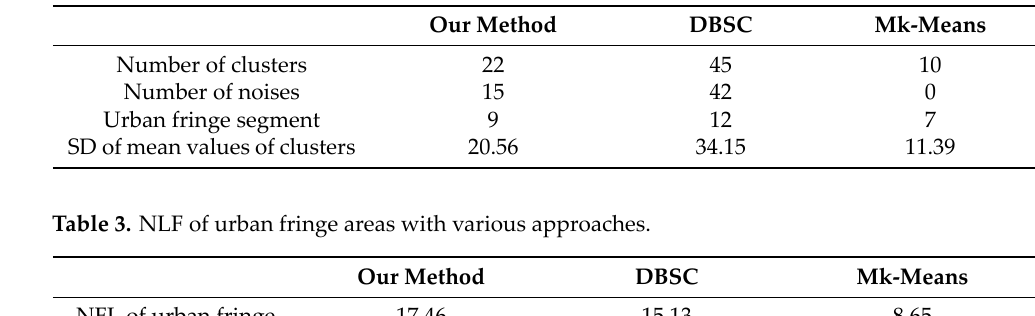
Table 2. The clustering results from statistical information.